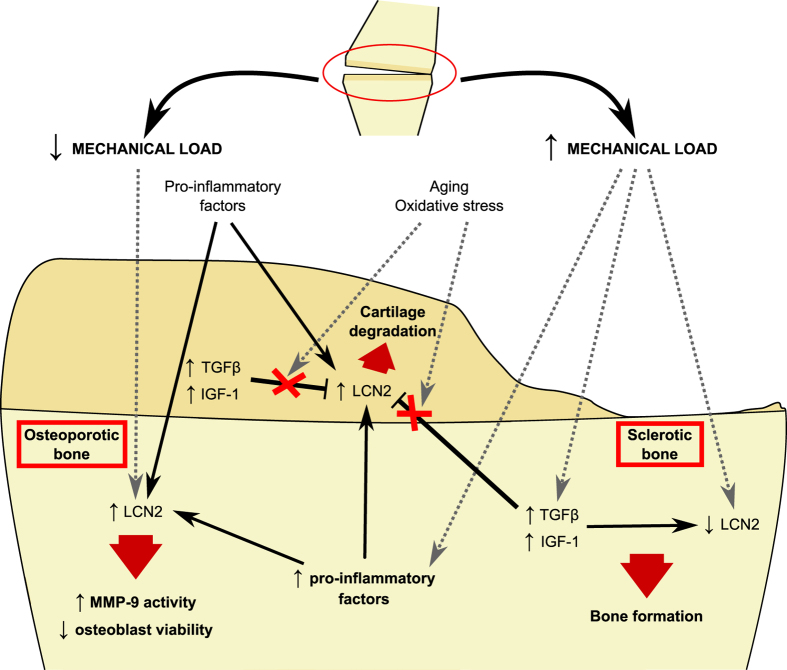
Speculative model of LCN2 regulation in the OA osteochondral junction.In the presence of alterations in articular biomechanics, joint tissues are subjected to different amounts of loading. Where the mechanical load is increased, LCN2 expression is decreased in bone, along with the up-regulation of growth factors, such as TGF-β1 and IGF-1, which might contribute to reduced LCN2 expression in osteoblasts. In this way, the bone exhibits higher bone formation and subchondral sclerosis. In areas of lower mechanical load, LCN2 expression is increased. In osteoblasts, this expression is enhanced by pro-inflammatory factors, which may originate from loaded bone and the inflamed environment. High LCN2 expression may have deleterious effects on bone, promoting MMP-9 activity and contributing to reduced osteoblast viability. Pro-inflammatory factors and other mediators derived from different joint tissues, including subchondral bone, may also induce LCN2 expression in the articular cartilage. Although TGF-β1 and IGF-1 also inhibit the induced expression of LCN2 in chondrocytes, impairment of their signalling pathways by oxidative stress, ageing, etc. may block this inhibition, thus leading to greater LCN2 expression and cartilage degradation during OA. Black lines indicate data described in this work, and grey dotted lines indicate data previously described8172451.